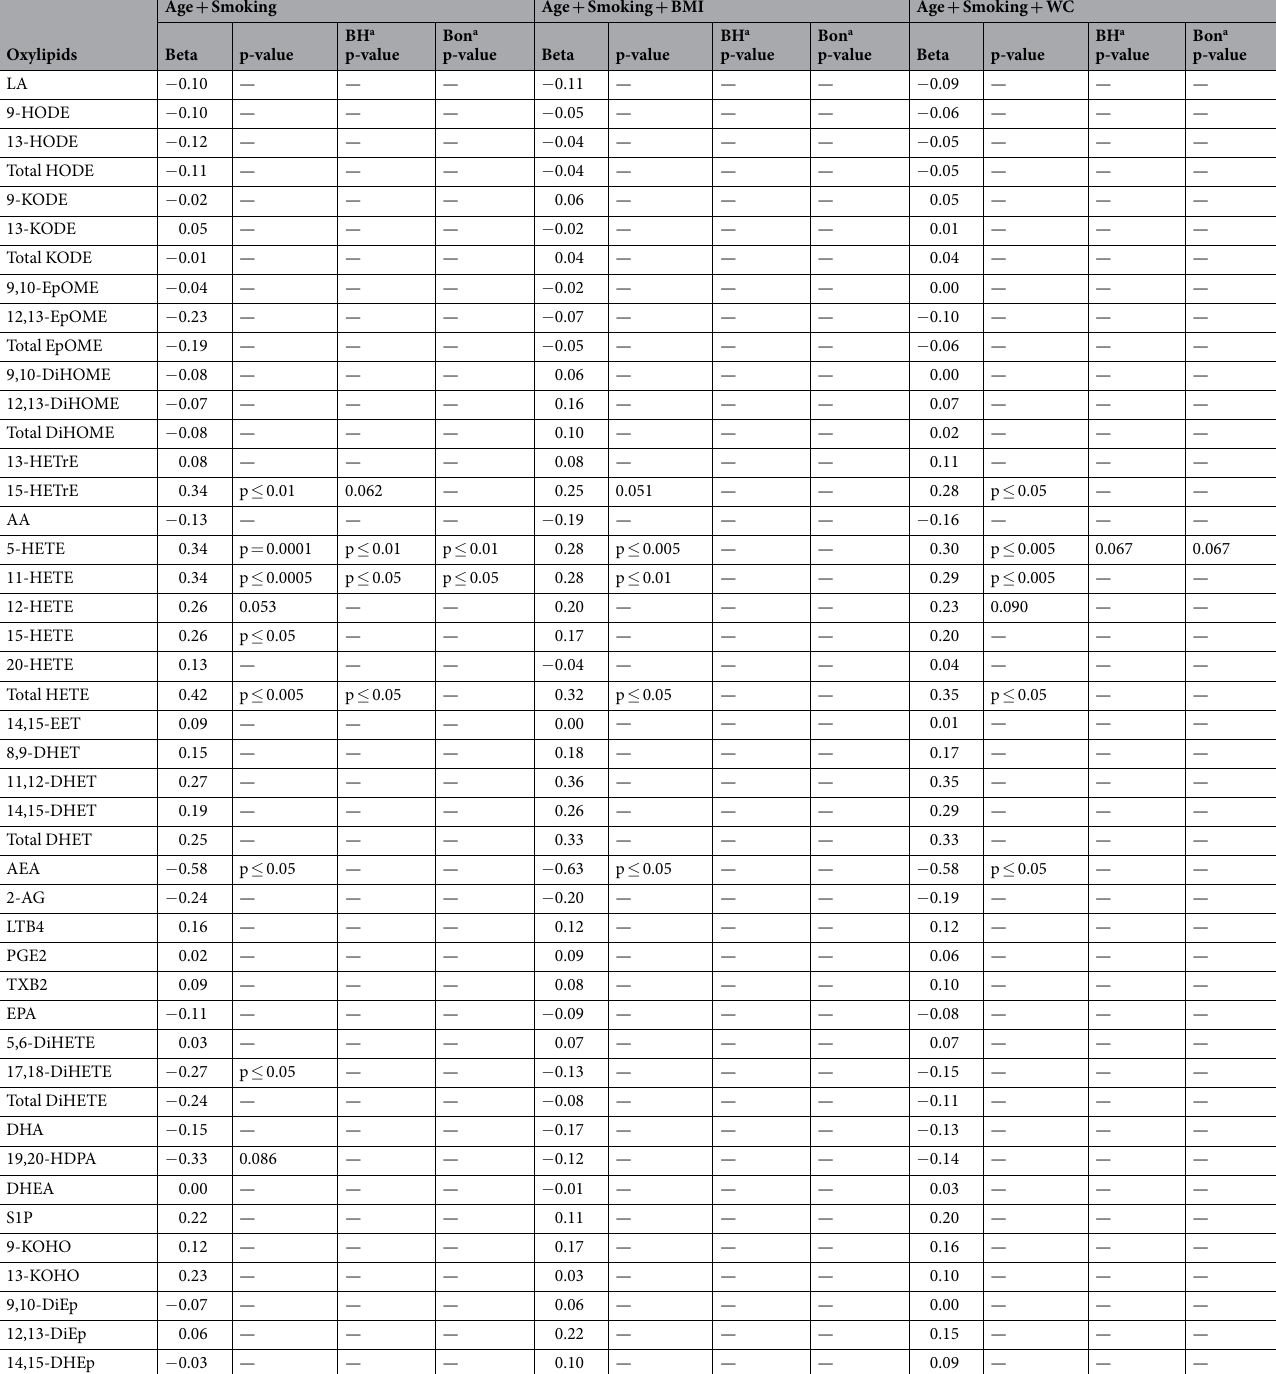
— — — Table 2. Association of arachidonic acid-derived oxylipids are associated with colon polyp type. Beta coefficients and p-values were determined through general linear regression with Poisson distribution. Models were defined as Polyp type = Age + Smoking + log(oxylipid), Polyp type = Age + Smoking + BMI + log(oxylipid), and Polyp type = Age + Smoking + WC + log(oxylipid). P-values were adjusted for false discovery rate (FDR) according to Benjamini-Hochberg and Bonferroni. Only p-values < 0.1 are displayed. Oxylipids totals calculated as follows: Total HODE = Σ 9-HODE + 13-HODE; Total KODE = Σ 9-KODE + 13-KODE; Total EpOME = Σ 9,10-EpOME + 12,13-EpOME; Total HETE = Σ 5-HETE + 11-HETE + 12-HETE + 15-HETE + 20-HETE; Total DHET = Σ 8,9-DHET + 11,12-DHET + 14,15- DHET; Total DiHETE = Σ 5,6-DiHETE + 17,18-DiHETE. a P-values were corrected for false discovery rate (FDR) according to Benjamini-Hochberg (BH) and Bonferroni